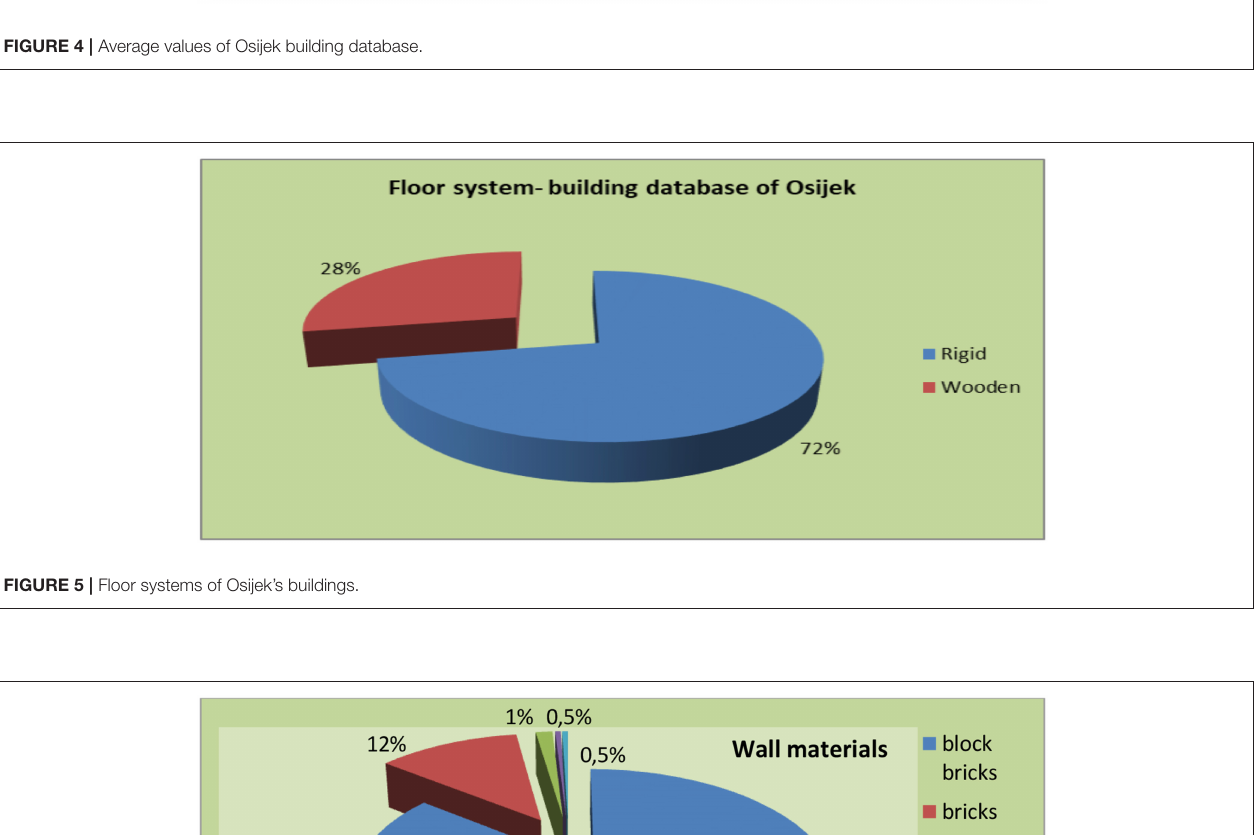
Frontiers in Built Environment |